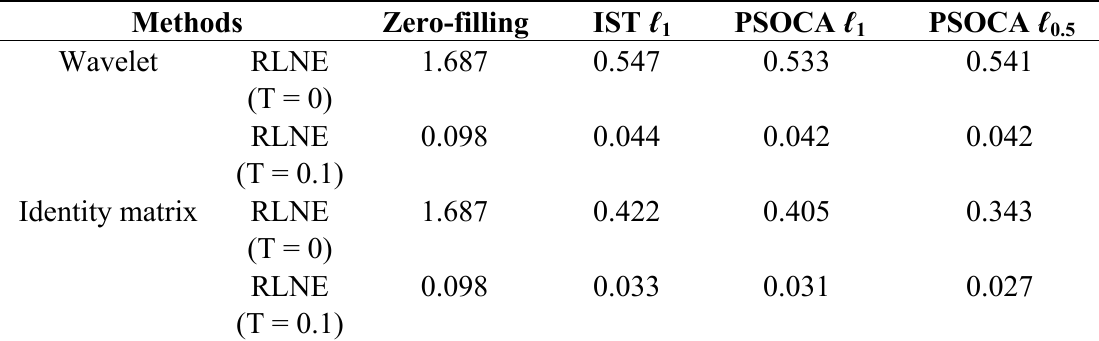
Table 2. Reconstruction error of a 1 H- 13 C COSY spectrum.